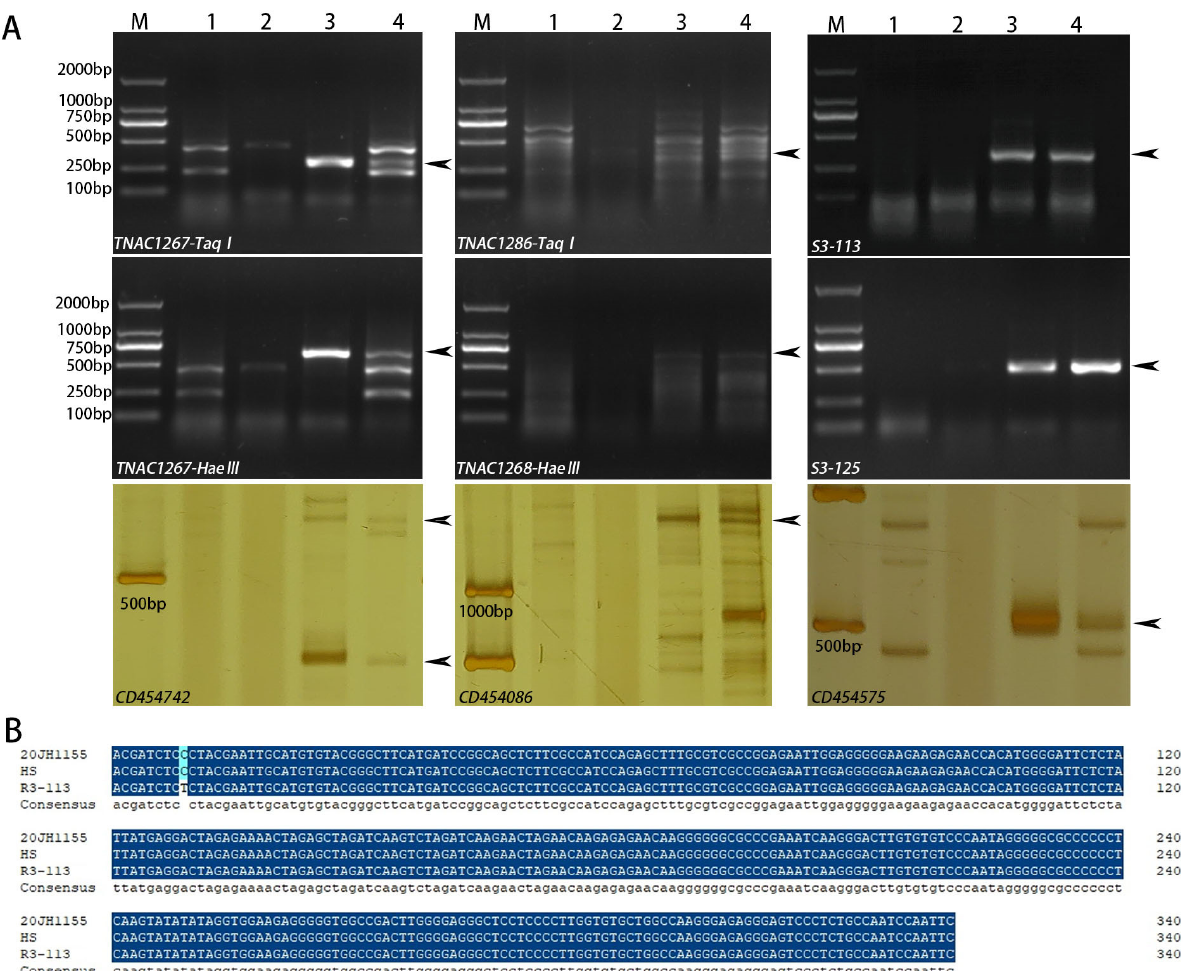
Figure 3. Molecular marker analysis of wheat- P. huashanica derived line 20JH1155. ( A ) EST, SSR, and PLUG markers, including TNAC 1267, TNAC1286, S3-113, S3-125, CD454742, CD454086, and CD454575, amplified the special bands of the third homoeologous. M: D2000. 1: 7182, 2: Trs-372. 3: P. huashanica . 4: 20JH1155. The black arrows indicate specific bands in the material and its alien parent. ( B ) Sequence alignment of 20JH1155, P. huashanica , and R3-113 by DNAMAN. HS means P. huashanica, and R3-113 is a special sequence of 3Ns in P. huashanica . The bases in dark blue indicated the same sequence of 20JH1155 , P. huashanica and R3-113, and in light blue meant di ff erent bases.